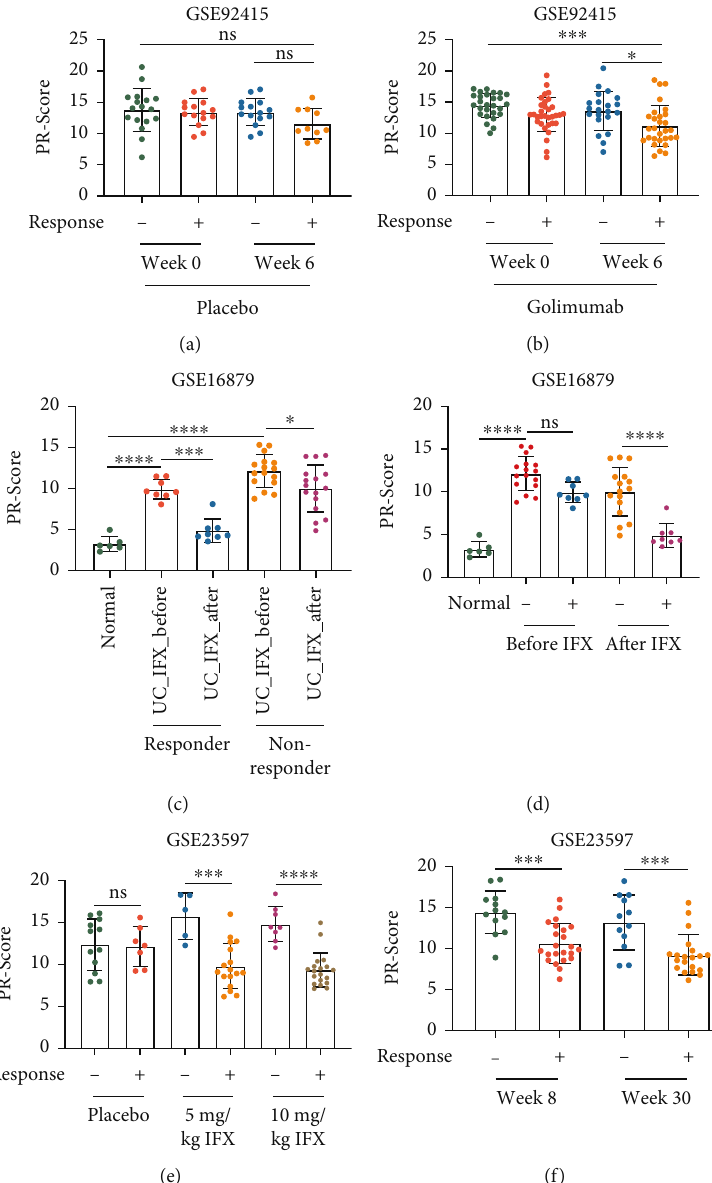
Figure 6: Di ff erences of the PR-Score in responders/nonresponders with anti-TNF treatment. Based on the GSE92415 dataset, UC patients were treated with placebo (a) and golimumab (b) for 6 weeks, respectively. The PR-Score was compared. According to the GSE16879 dataset, the PR-Score was compared between UC patients before and after IFX treatment (c), or between responders and nonresponders (d). Based on the GSE23597 dataset, compare the e ff ects of IFX doses (e) and the time of IFX administration (f) on the PR-Score in patients with IFX response. UC: ulcerative colitis; IFX: in fl iximab. ∗ P < : 05 , ∗∗ P < : 01 , ∗∗∗ P < : 001 , and ∗∗∗∗ P < : 0001 . ns: not signi fi